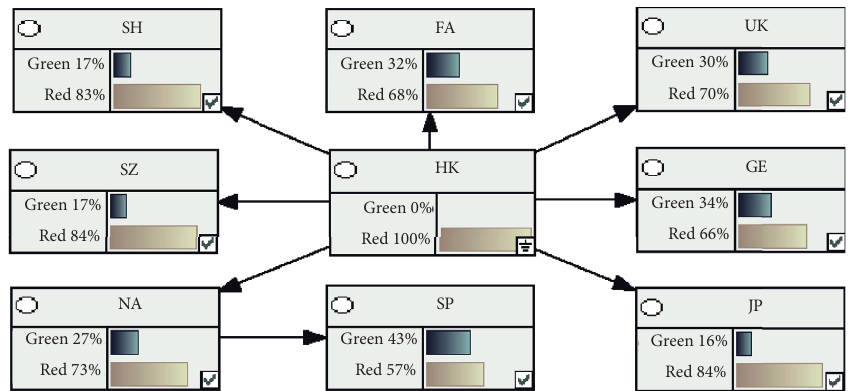
Figure 5: BN final state diagram